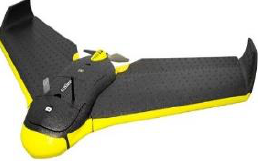
Figure 1. UAV – eBee with a fixed wing by senseFly